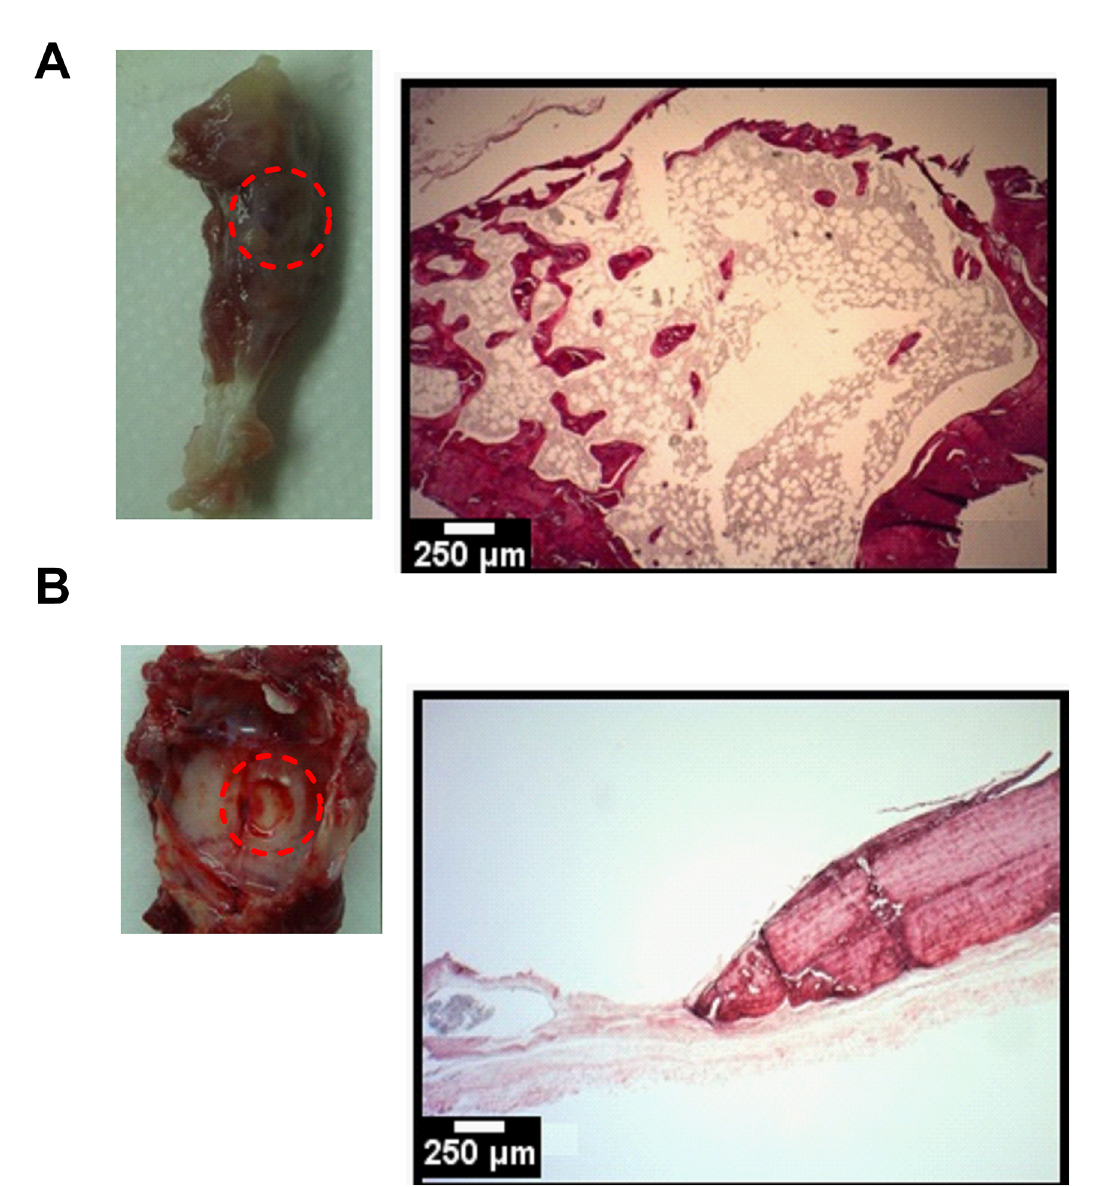
Figure 2. Control groups: A-B) Samples T1 and P1 after 32 days of culture with histological data, H&E staining, 250µm scale bar 250µm; the red circle indicates the site of the critical